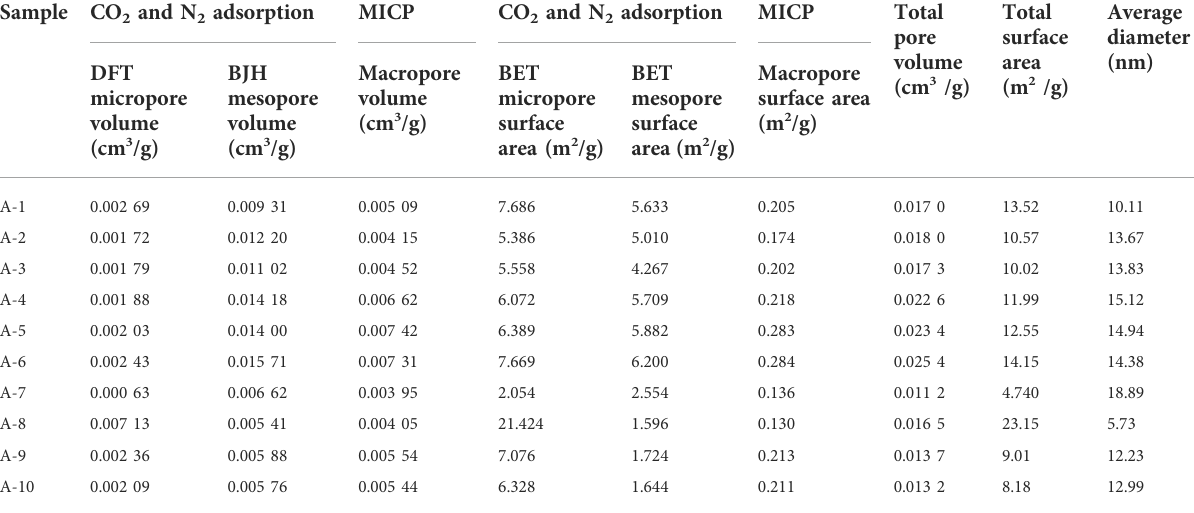
TABLE 2 Pore structure parameters determined by CO 2 , N 2 adsorption experiments and MICP experiments.